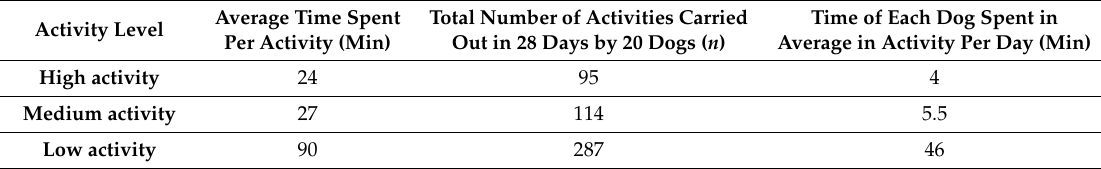
Table 4. Time spent at di ff erent activity levels and total number of activities carried out in 28 days by all 20